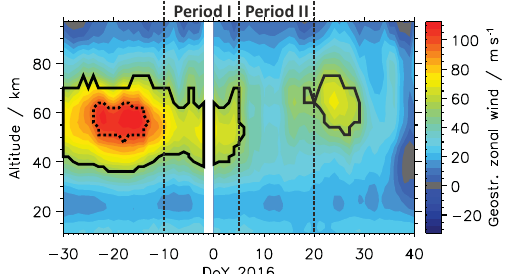
Figure 5. Time–altitude cross sections of the zonal mean zonal wind averaged between 40 and 50 ◦ N. Areas enclosed by dotted (solid) black lines display areas with a negative refractive index squared n 2 for the SPW 1 (2), i.e., areas where the vertical propagation of the SPW is prohibited. Data are derived from MLS.